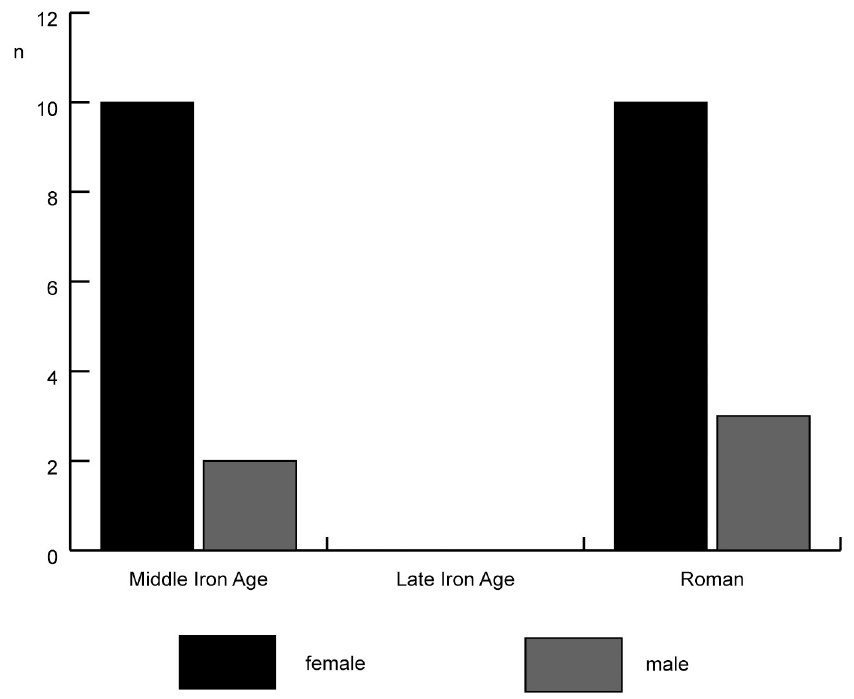
Fig 5. Sex ratios for cattle from Houten-Castellum based on the shape of the pubic bone.